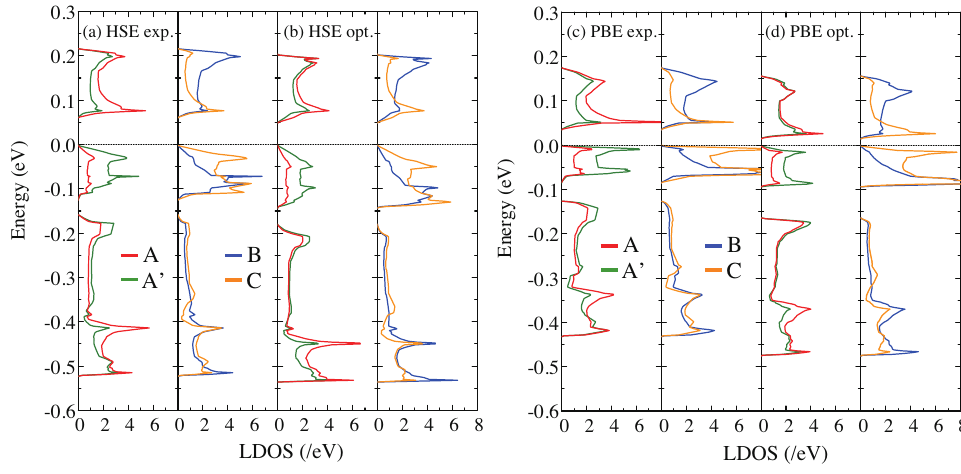
Figure 3. The band structure and the total DOS for the experimental structure at 30 K, in the CO phase calculated with the ( a ) HSE06 and ( b ) GGA-PBE functionals and those for the geometrically optimized structure with the ( c ) HSE06 and ( d ) GGA-PBE functionals.